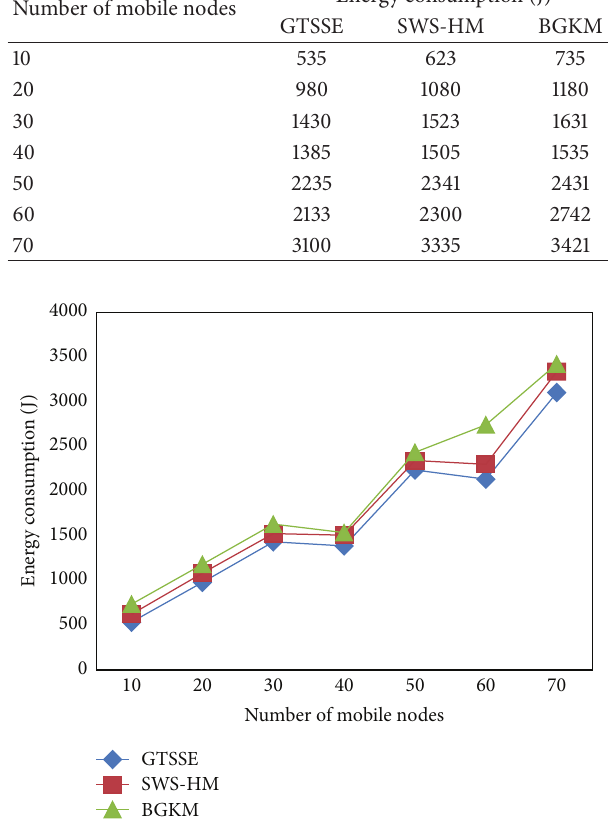
Figure 4: Energy consumption for three methods GTSSE, SWS- HM, and